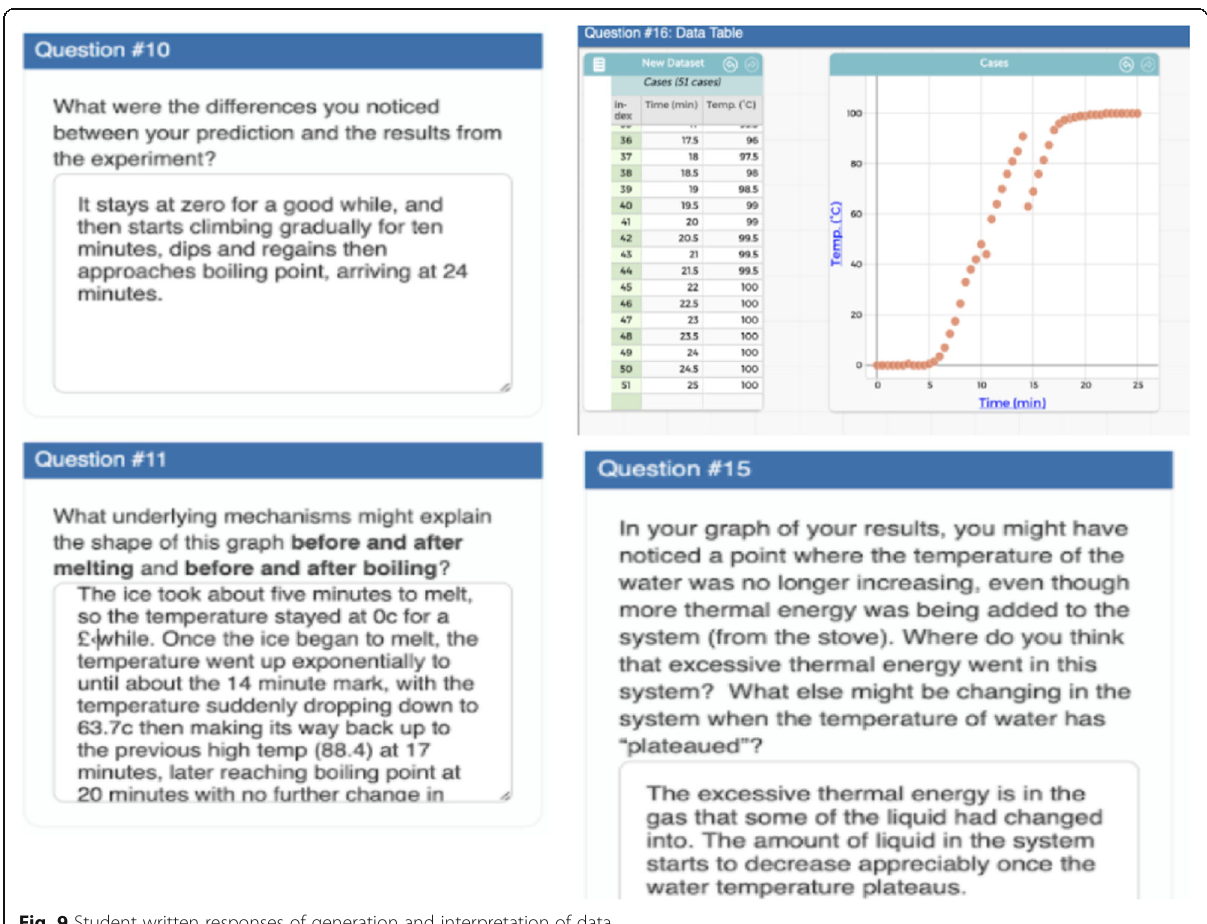
Fig. 9 Student written responses of generation and interpretation of